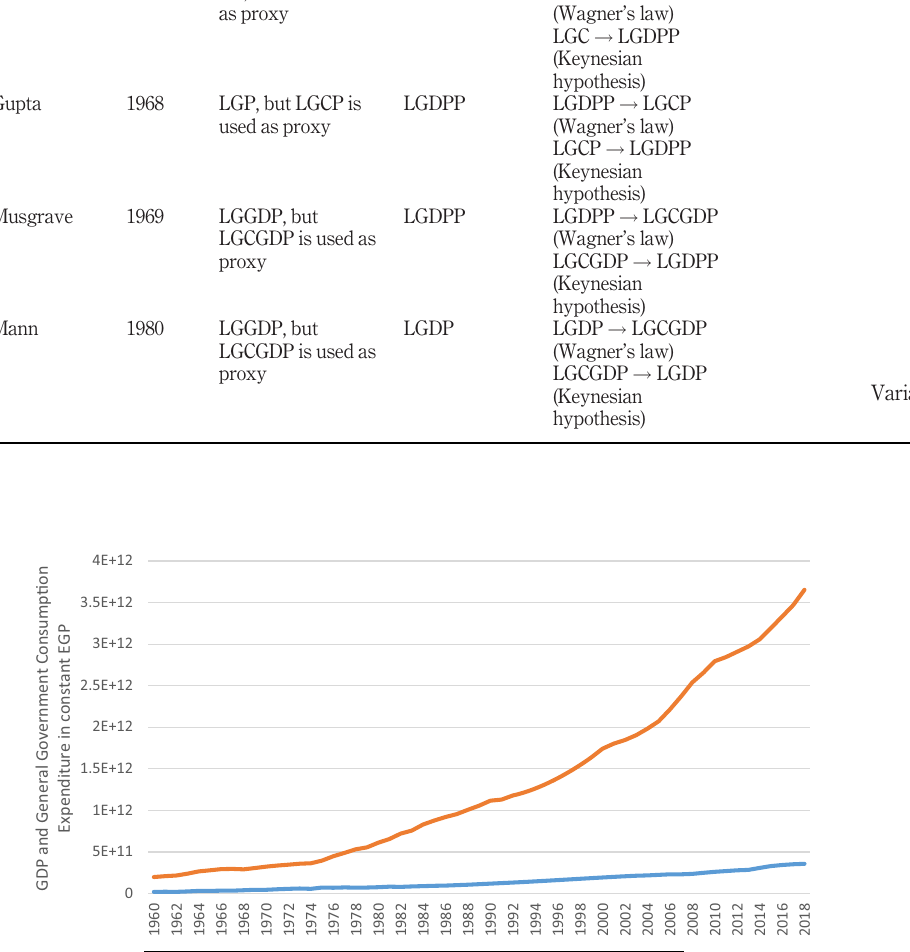
Figure 1. Real GDP